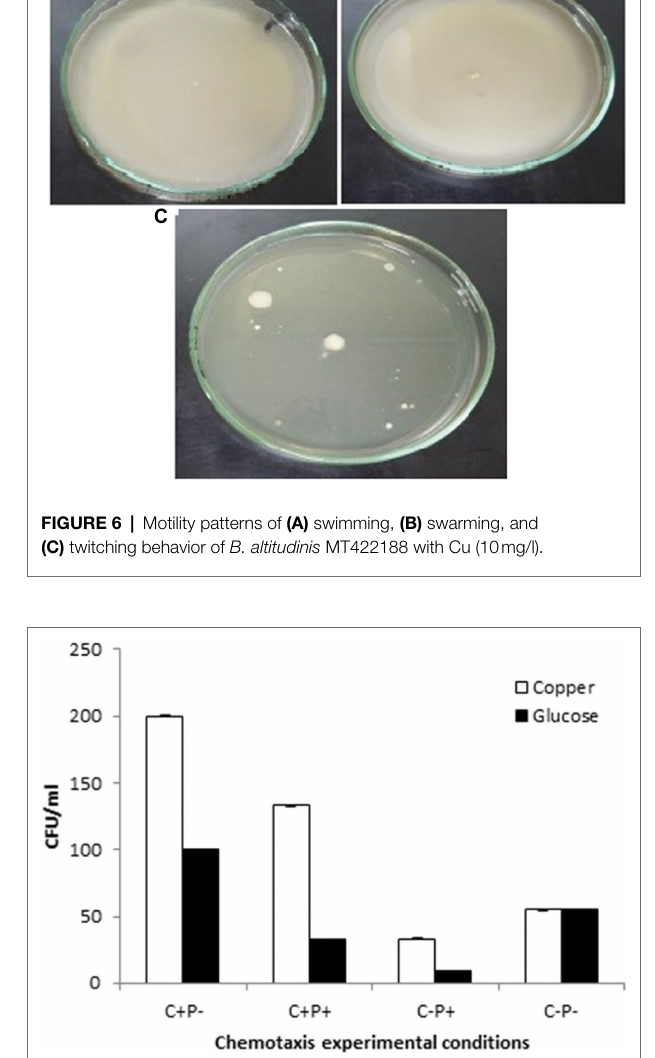
FIGURE 7 | Chemotactic pattern of B. altitudinis MT422188 in 4 different setups with Cu and control (glucose). (+) = Cu present, ( − ) = Cu absent, C = capillary, and P =